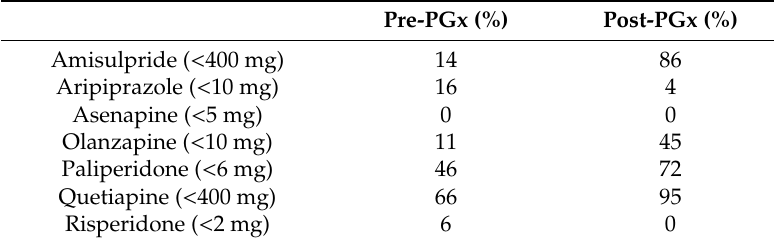
Table 4. Infratherapeutic dosage percentage.